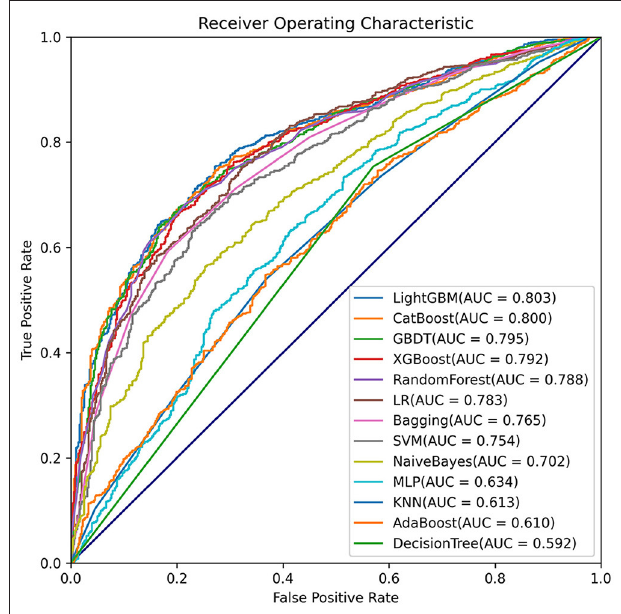
FIGURE 2 | Comparisons of different machine learning